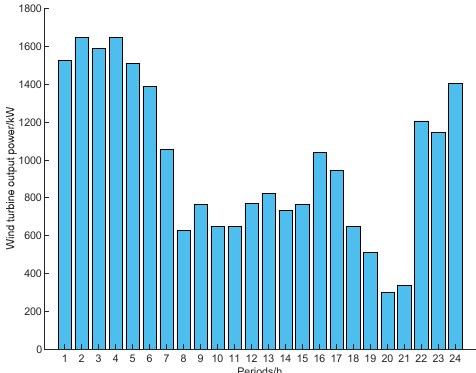
Figure 4. Optimal charging strategy for the EV users.